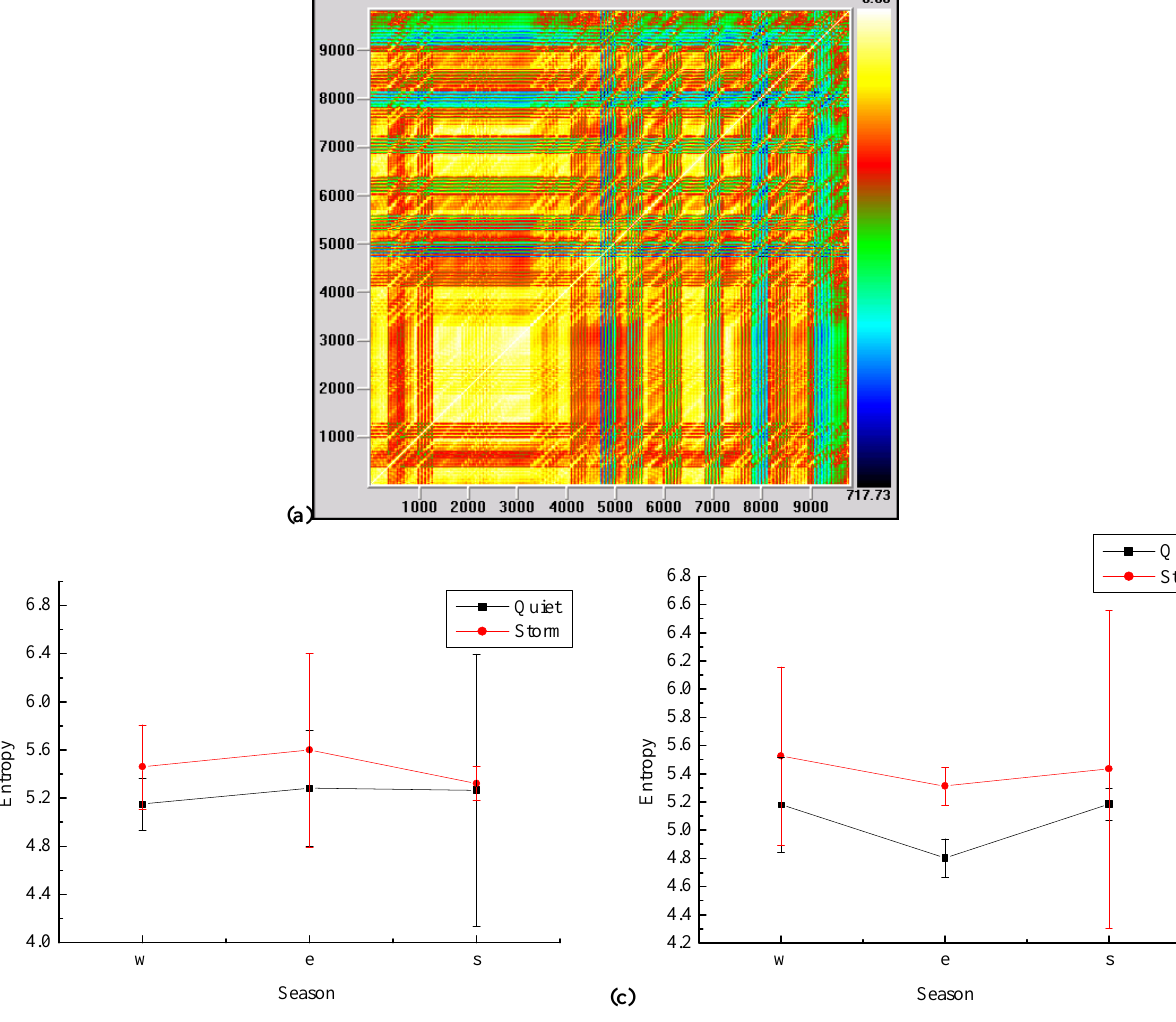
Fig. 5. (a) Recurrence plot (RP) of the AE index time series, during the quiet period, 5–11 January 1991, which exhibit characteristic Figure 5c patterns. Comparison of seasonal mean values of entropy of AE index time series for summer, equinox and winter (denoted by letters, “s”, “e”, and “w” respectively on x-axis) for quiet and storm periods (red and black lines respectively) during (b) high (1991), and (c) low (1994) solar activity years . The vertical bars represent the standard deviation (red for storm and black for quiet